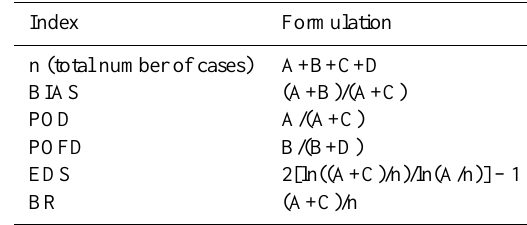
Table 2. Verification indices based on 2 × 2 contingency table. See Table 1 for the definition of A, B, C and